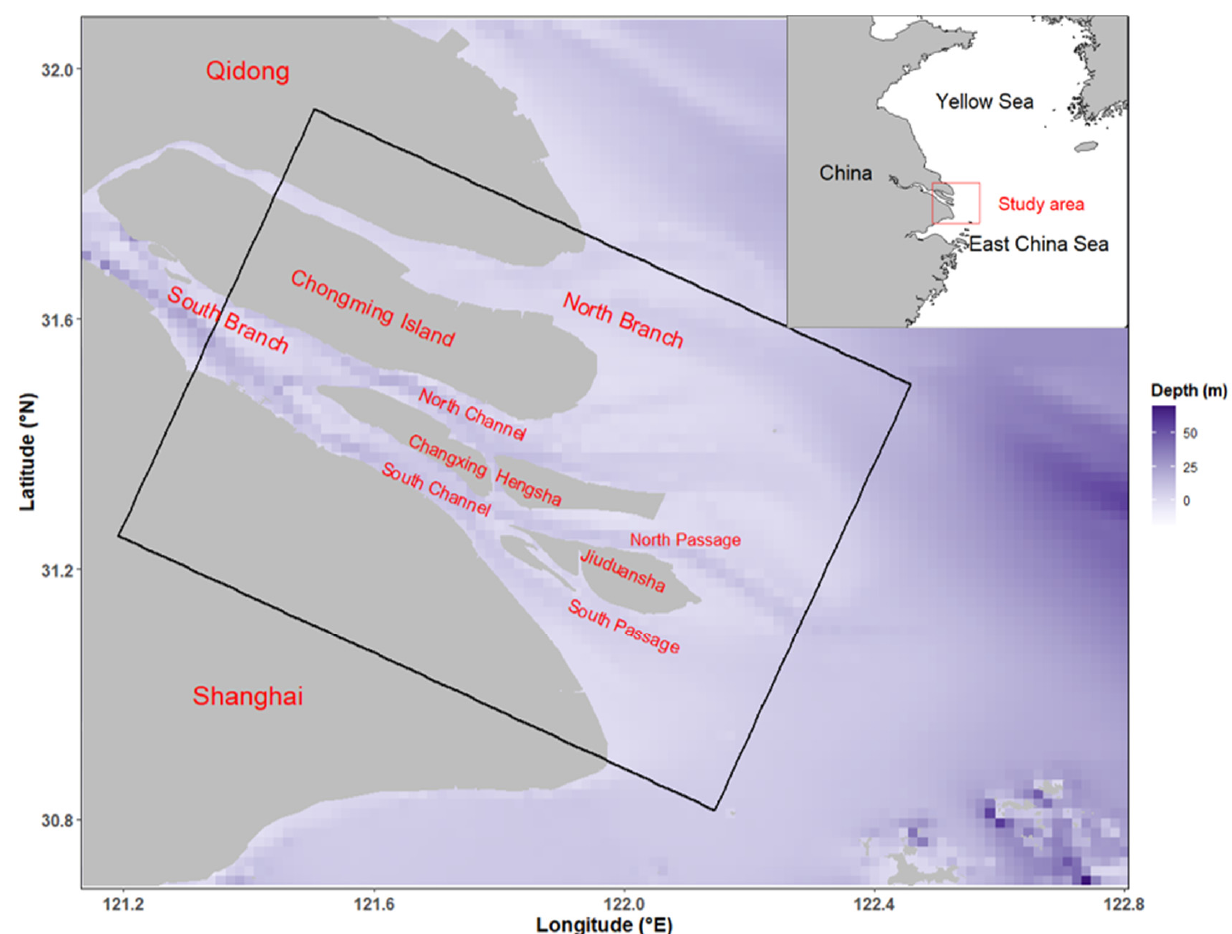
Figure 1. Location of study area in the Yangtze Estuary.